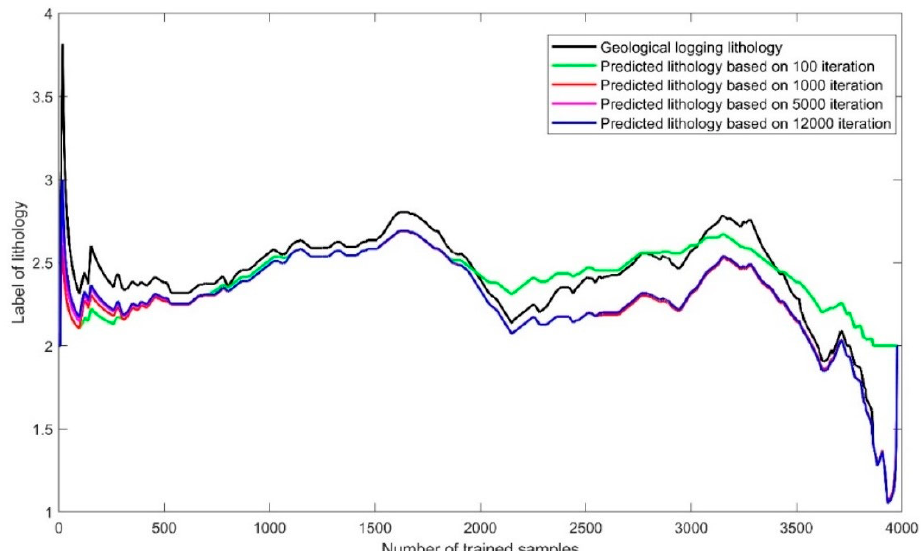
Figure 10. ( a ) Cost value of different iterations of BP neural network. ( b ) Weight of different attributes of training samples. ( c ) Comparison of the predicted lithology of training samples under different iterations.